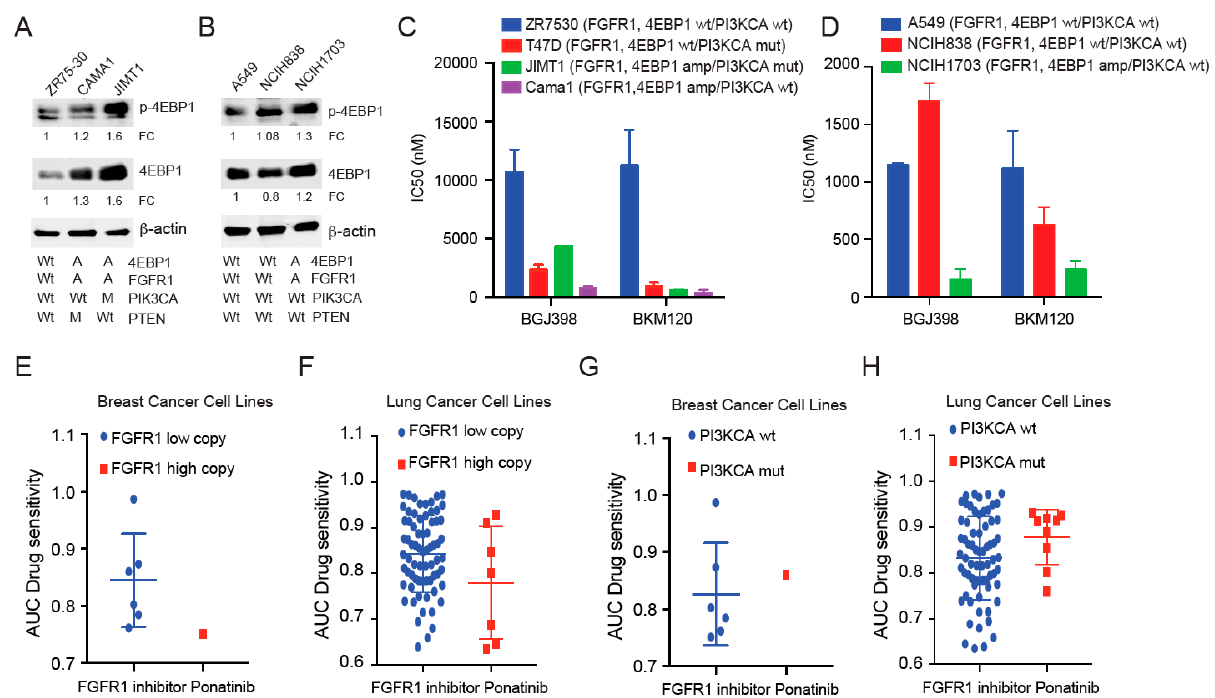
Figure 2. Loss of 4EBP1 results in activated translation and reduced sensitivity to FGFR1 and PI3K inhibition. ( A , B ) Immunoblot analysis shows 4EBP1, p-4EBP1 (Ser 65), p-FGFR1, and FGFR1 levels in breast ( A ) and lung cancer ( B ) cell lines with wild-type or amplified 4EBP1. b-actin was used as the loading control. Quantification of respective proteins is indicated as fold change (FC) normalized to b-actin and FGFR1-4EBP1 wild-type cells. The uncropped blots for all the experiments are shown in Figure S6. ( C , D ) IC50 analysis for FGFR1 inhibitor BGJ398 and pan-PI3K inhibitor BKM120 in levels in breast ( C ) and lung cancer ( D ) cell lines with wild-type or amplified 4EBP1. ( E–H ). DepMap dataset showing the sensitivity to FGFR1 inhibitor ponatinib in FGFR1-amplified ( E , F ) and PI3K-mutant ( G , H ) compared to wild-type cells in a panel of breast and lung cancer cell lines.